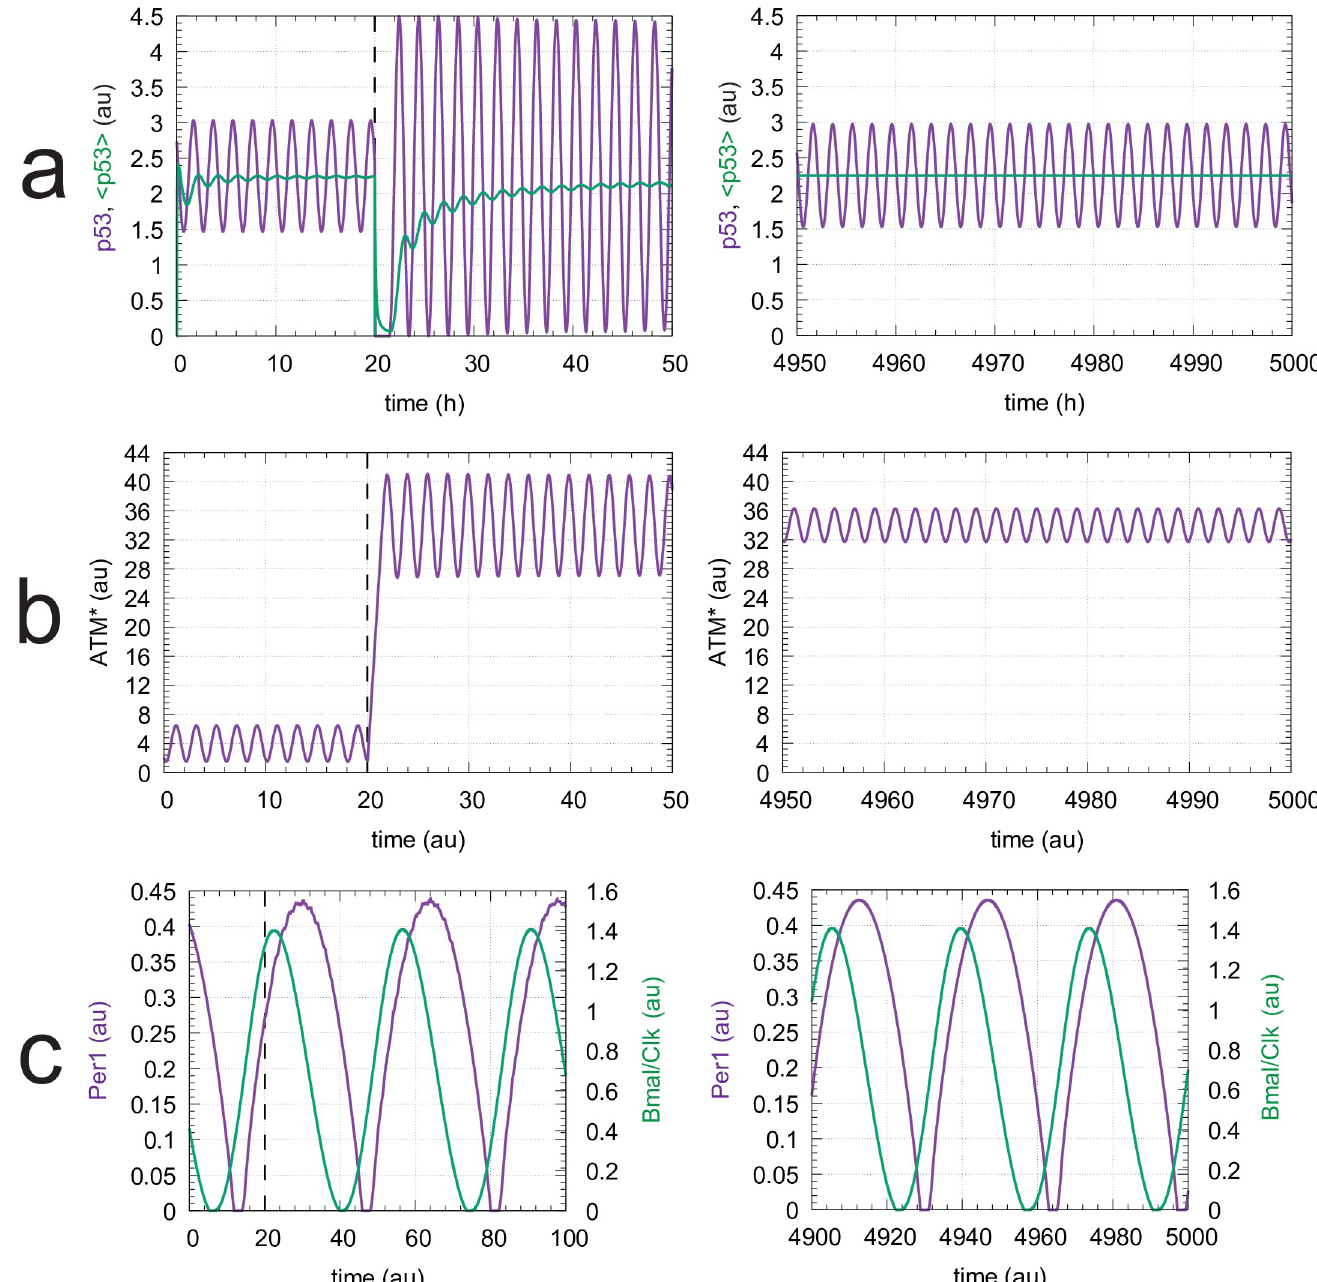
Fig 11. The ATM � controller defends its s -dependent set-points (Eq 24) towards outflow perturbations. Row a, left panel: p53 oscillations and average p53 levels, < p53 > , as a function of time with s = 1.0. At time t = 20h k 2 is increased from 10.0 to 50.0. Row a, right panel: average p53 concentration is back at the controller’s set-point (2.25) with an unchanged period length of 1.99h. Row b, left and right panels: Upregulation of ATM � due to the change in k 2 . Row c, left and right panels: oscillations in Per1 and Bmal/Clk are unaffected by the k 2 perturbation. Initial concentrations and rate parameters as in Figs 10c and 9.